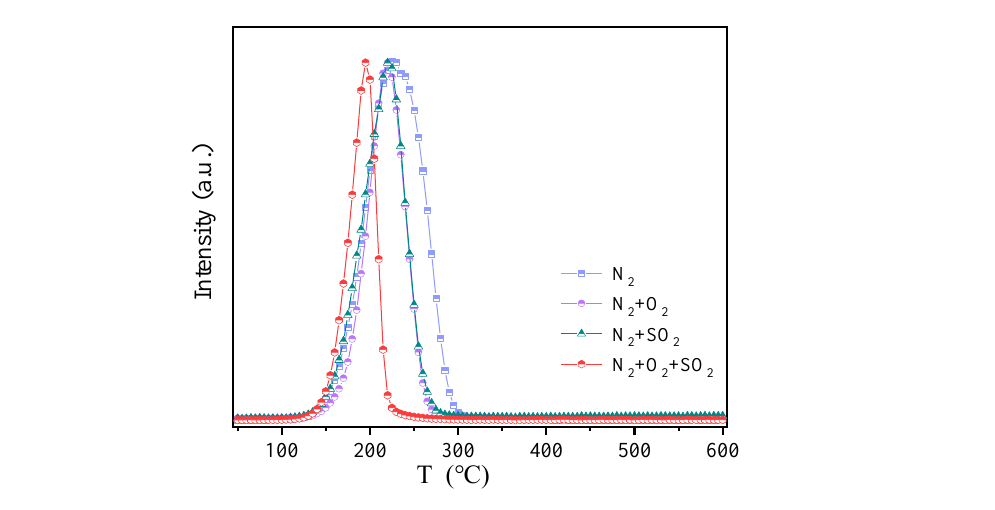
Figure 11. The TPD curves of spent samples after Hg 0 adsorption under different atmospheres.